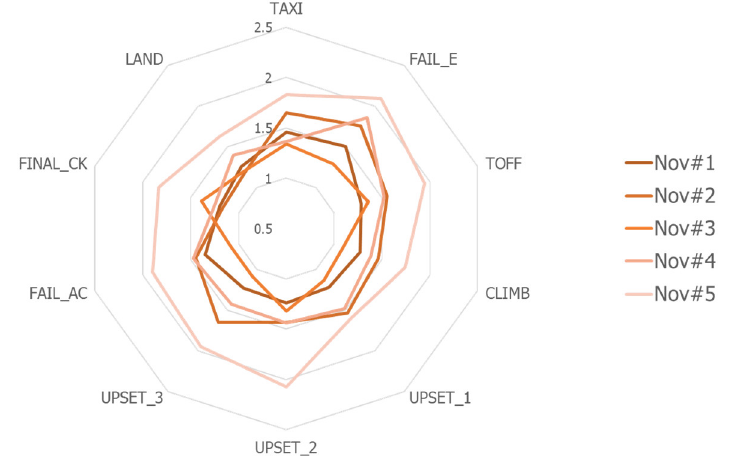
Figure 9. Reporting the MF’ values for each flight phase and pilot allowed for the identification of the condition(s) and pilot(s) who deviated more with respect to the Expert